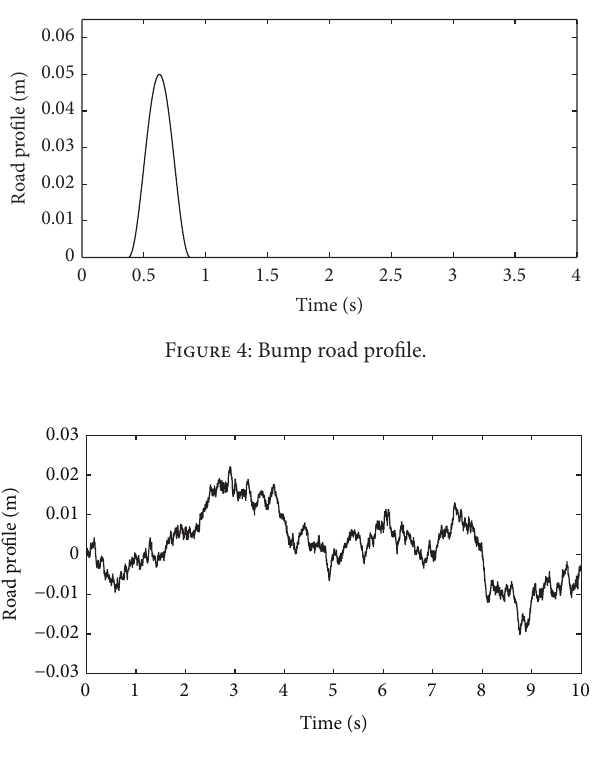
Figure 5: Random road